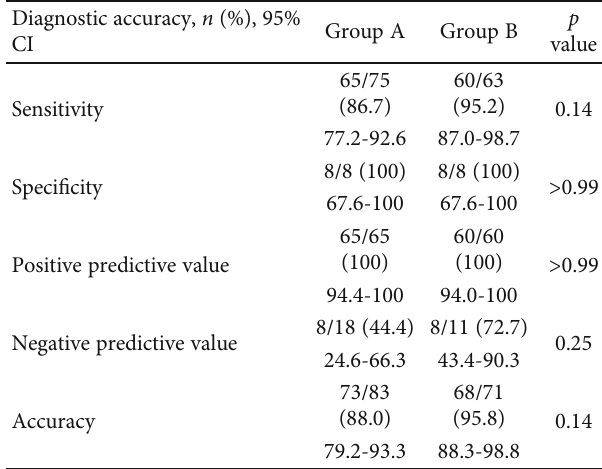
Table 6: Histological diagnostic accuracy comparisons between the conventional (Group A) and Franseen (Group B) needle groups.